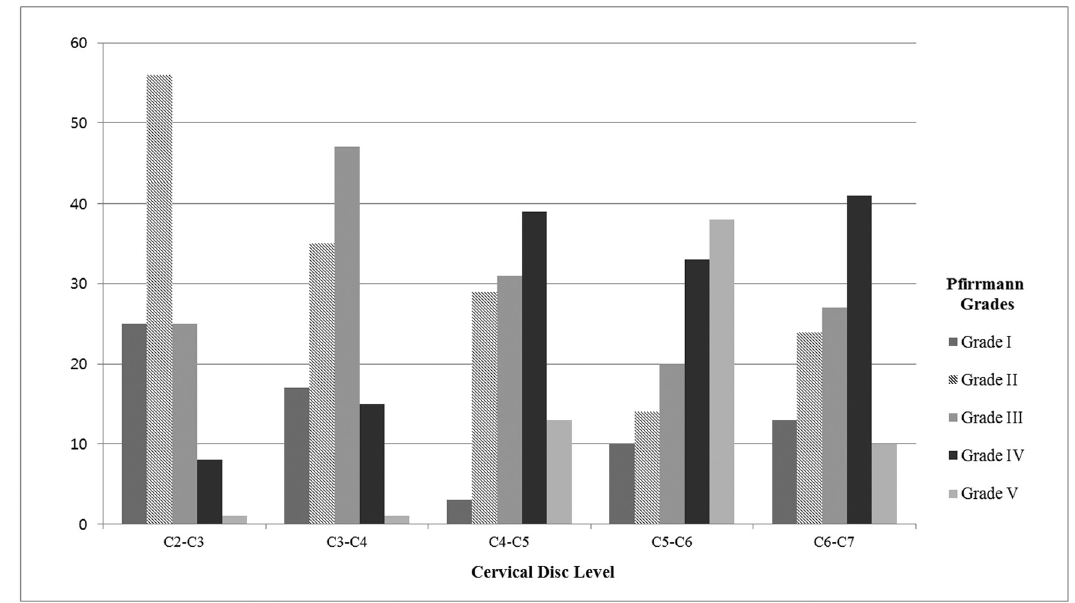
Figure 2: Number of patients with cervical disc degeneration assessed using P fi rrmann grades.